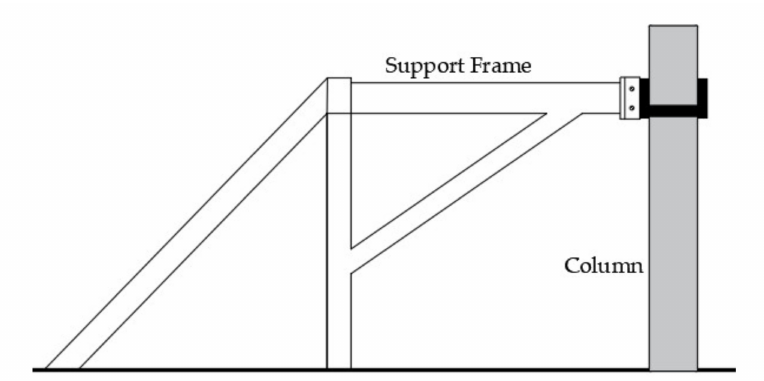
Figure 4. Test setup